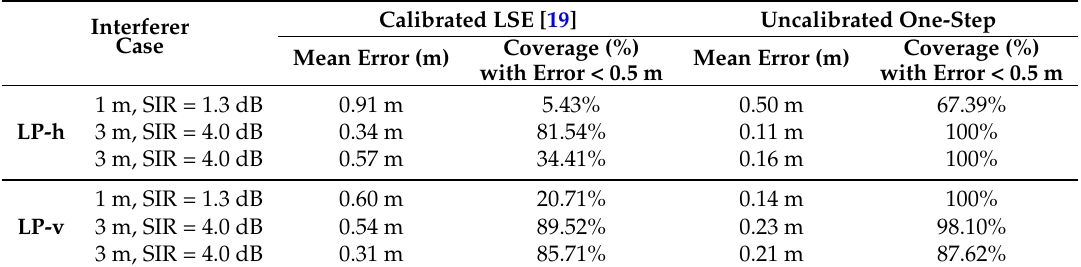
Table 8. Overall Tracking Y-path estimation errors with